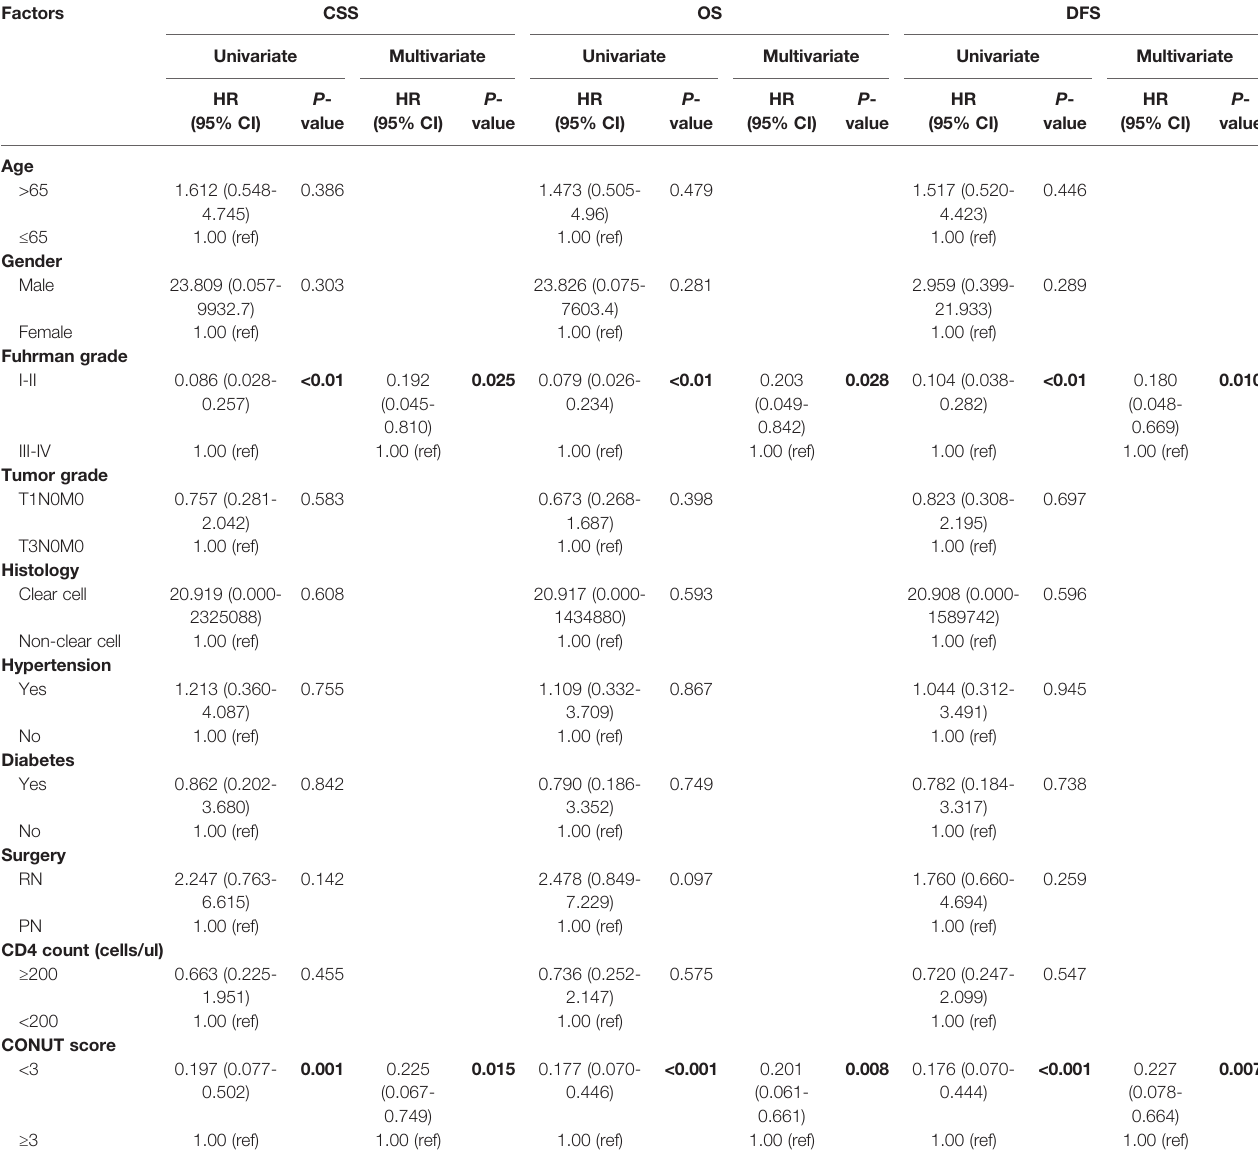
Bold values indicate statistical signi fi cance in univariate and multivariate analysis which had been detailed in the “ Results ” section. RCC,renalcell carcinoma;OS, overallsurvival;CSS,cancer-speci fi csurvival;DFS,disease-free survival;HR,hazardratio;CONUT,controlling nutritionalstatus;RN,radicalnephrectomy; PN, partial